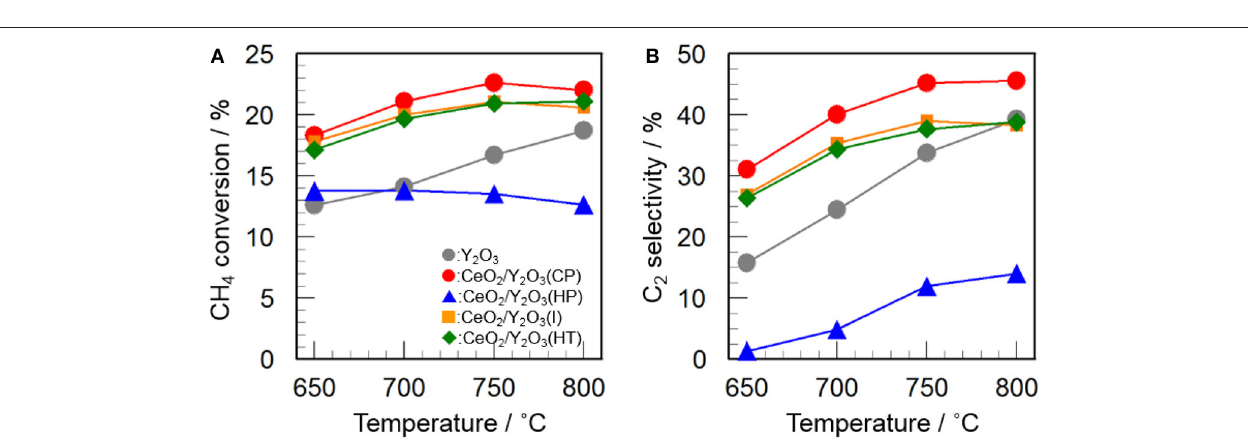
FIGURE 2 | Catalytic activity of 3 mol% CeO 2 /Y 2 O 3 for the OCM reaction. (A) CH 4 conversion and (B) C 2